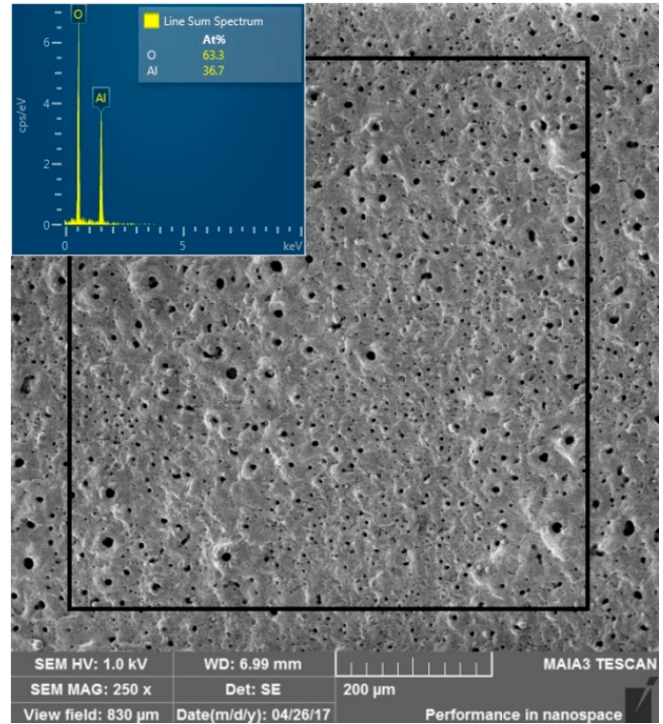
Figure 4. Surface area morphology investigated by SEM and elemental composition investigated by energy dispersive X-ray spectroscopy (EDS) after PEO treatment.